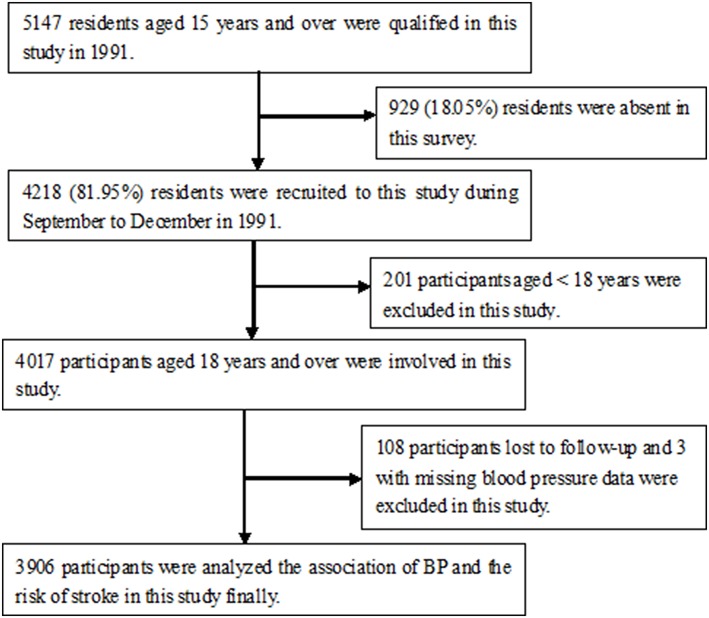
Flow chart showed that 4,218 were recruited into this survey (response rate = 82%), among 5,147 individuals aged ≥15-years-old. Of these, 4,017 individuals were ultimately enrolled, after excluding 201 individuals aged < 18 years. During the course of the study, 108 participants were lost to follow-up, and three with missing baseline BP data were removed from the BP analysis. Finally, a total of 3,906 participants were analyzed in this study.